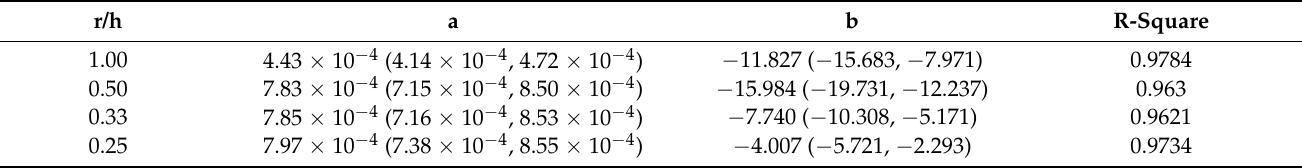
Table 8. Coe ffi cients of linear fi t for function a x + b with 95% con fi dence bounds for Figure 16.